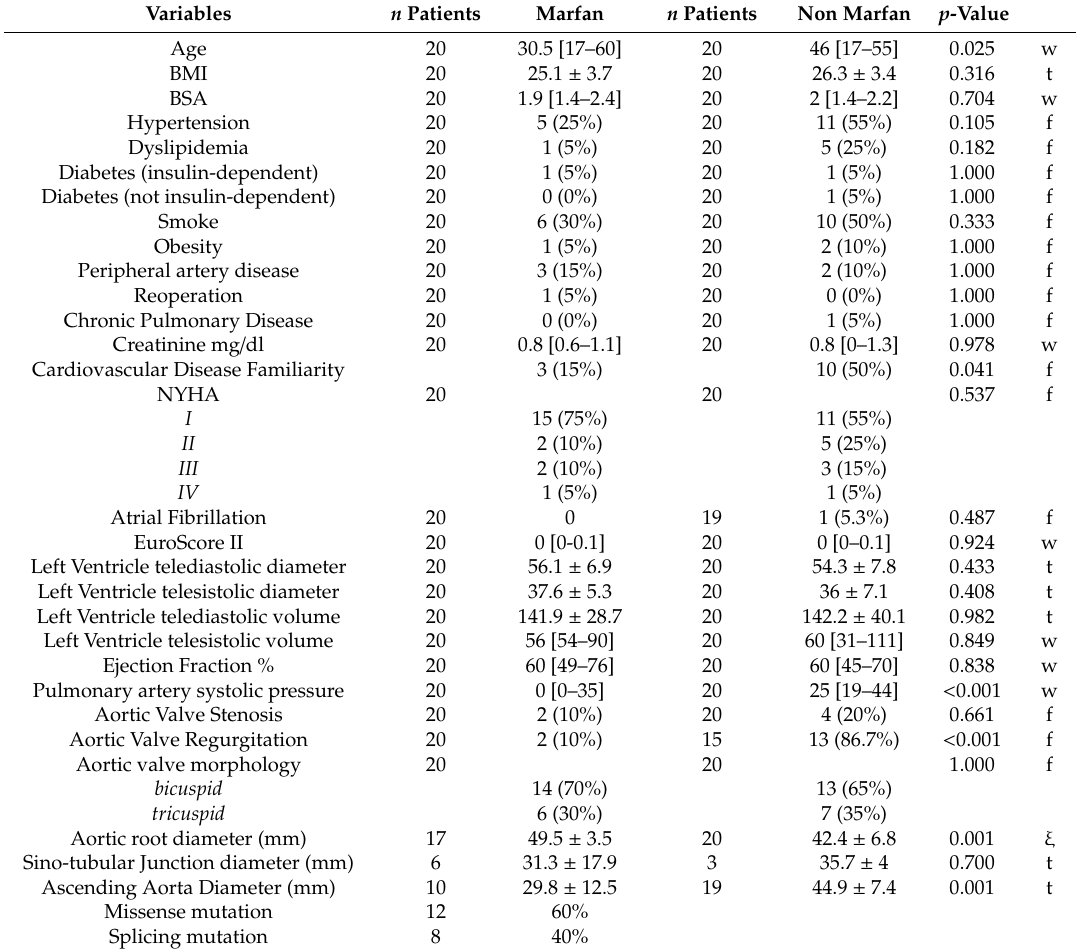
Table 1. Demographic and clinical characteristics of the study